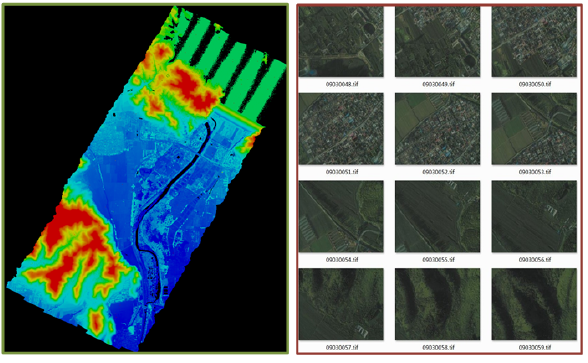
Figure 4: The example images of the Beijing Airborne Data. Left : LiDAR data, Right : remote sensing images of the surveying